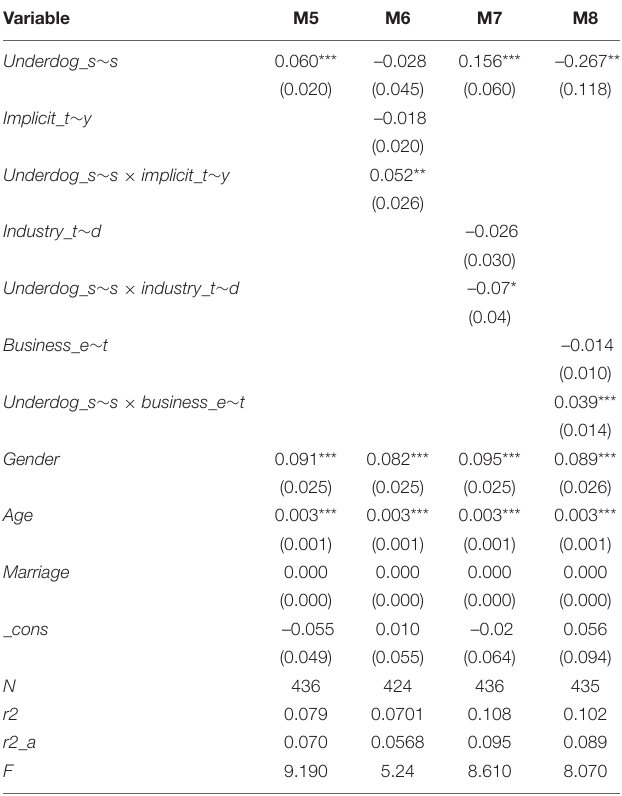
TABLE 5 | Regression analysis results of underdog status, three moderating variables and entrepreneurial resource efficiency (ESIEC